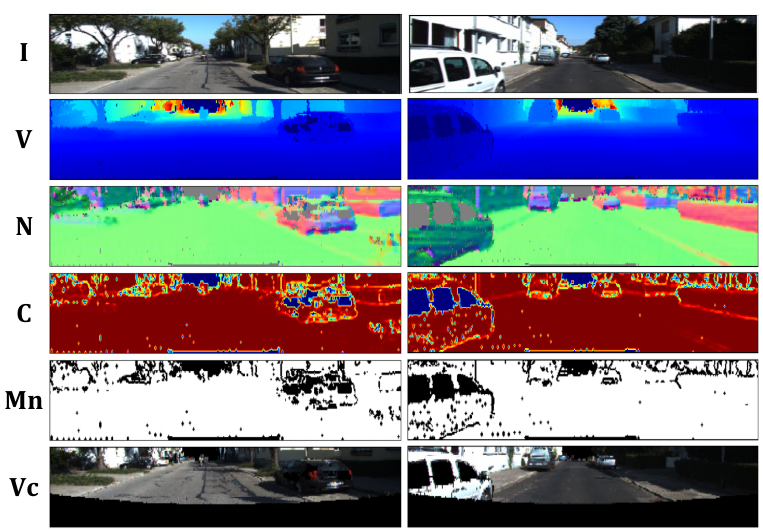
Figure 2. Typical examples in sequence 00 of KITTI. The visual image I , vertex map V , normal map N , normal confidence map C , normal binary mask Mn , and vertex color map Vc are presented from top to